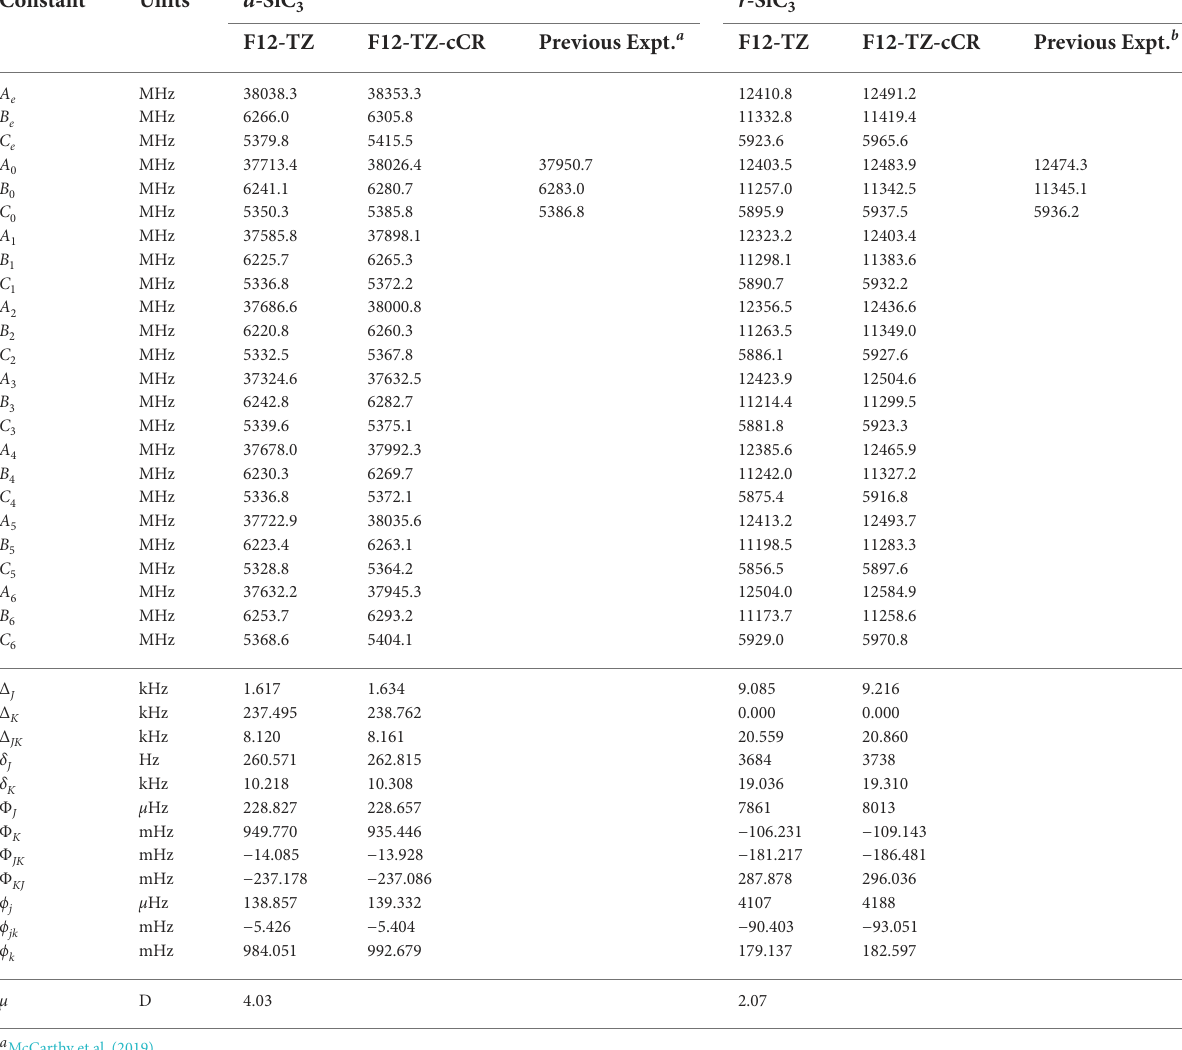
TABLE 3 Equilibrium( e ),vibrationally-averaged( 0 ),andsingly-vibrationallyexcited( n >0 )principalrotationalconstants,quartic( Δ / δ )andsextic( Φ / ϕ ) distortionconstants,anddipolemoments ( μ ) forSiC 3 Isomers.